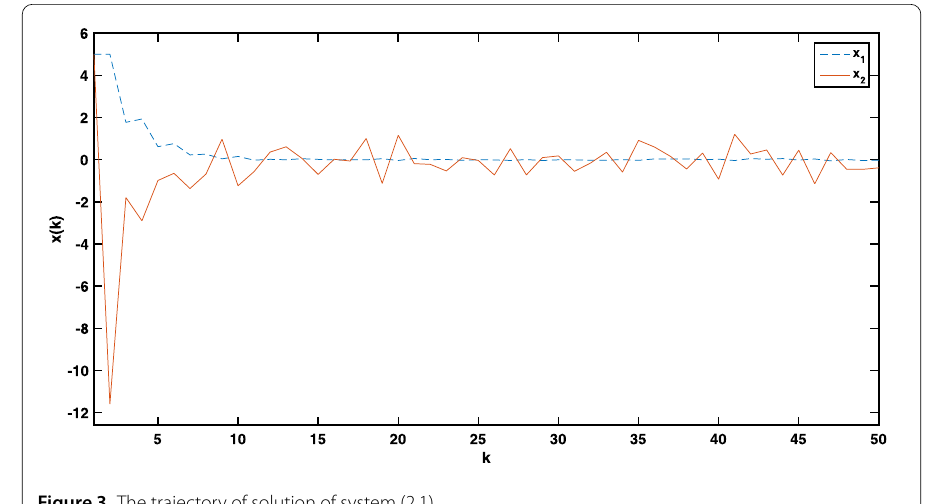
(cid:19) (cid:19) w ( k )